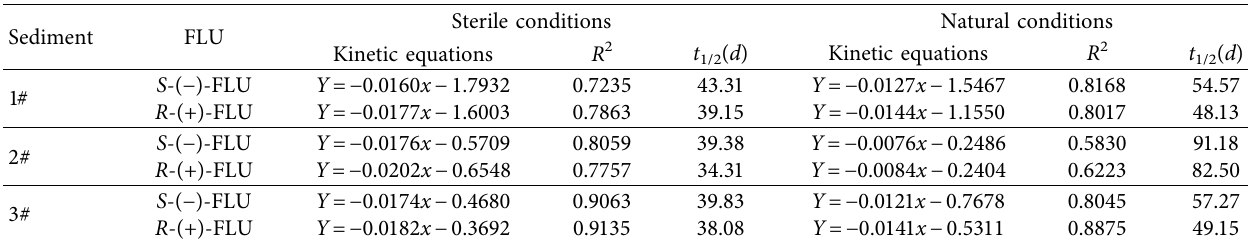
Table 3: Te degradation of kinetic equations and half-life period under sterile and natural conditions.